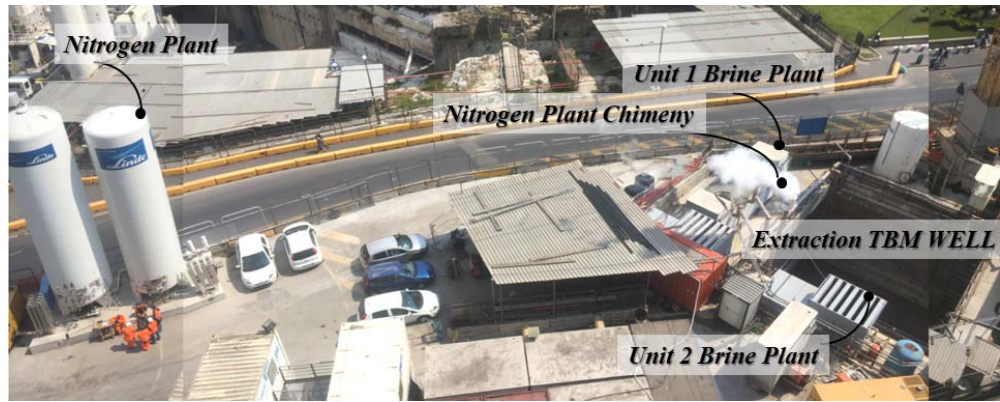
Figure 2. Overview of the construction site and view of the nitrogen and brine plant.